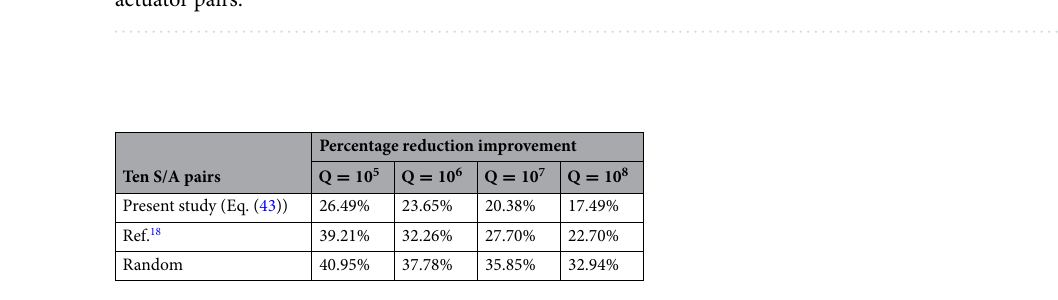
Table 4. Closed-loop average dB gain reduction for the cantilever thick bonded with ten piezoelectric sensor/ actuator pairs.